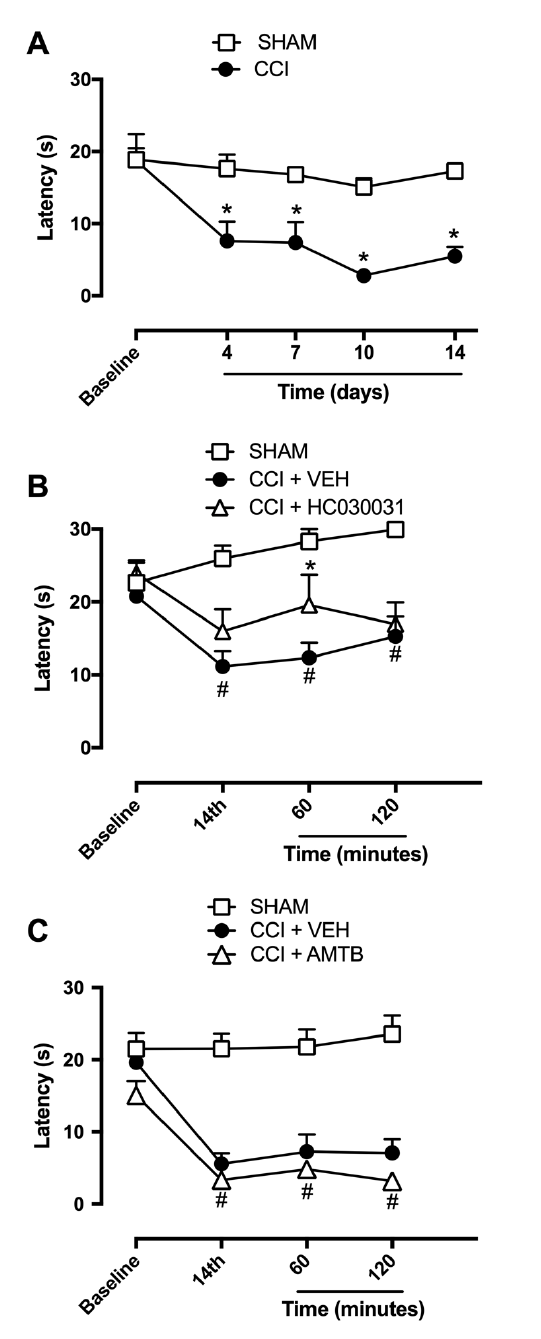
FIGURE 3 - Time course of (A) cold hyperalgesia (cold plate test) in CCI and SHAM rats, and effect of intraplantar injection with (B) TRPA1 and (C) TRPM8 antagonists, HC-030031 and AMTB, respectively, on cold hyperalgesia in CCI animals, 60 and 120 min after treatment (300 μg/40 μL/paw). Values represent mean ± SEM. # indicates p<0.05 when compared to the SHAM group and * indicates p<0.05 when in comparison to the CCI group treated with vehicle (CCI+VEH). Repeated-measures two-way ANOVA followed by Bonferroni’s post hoc